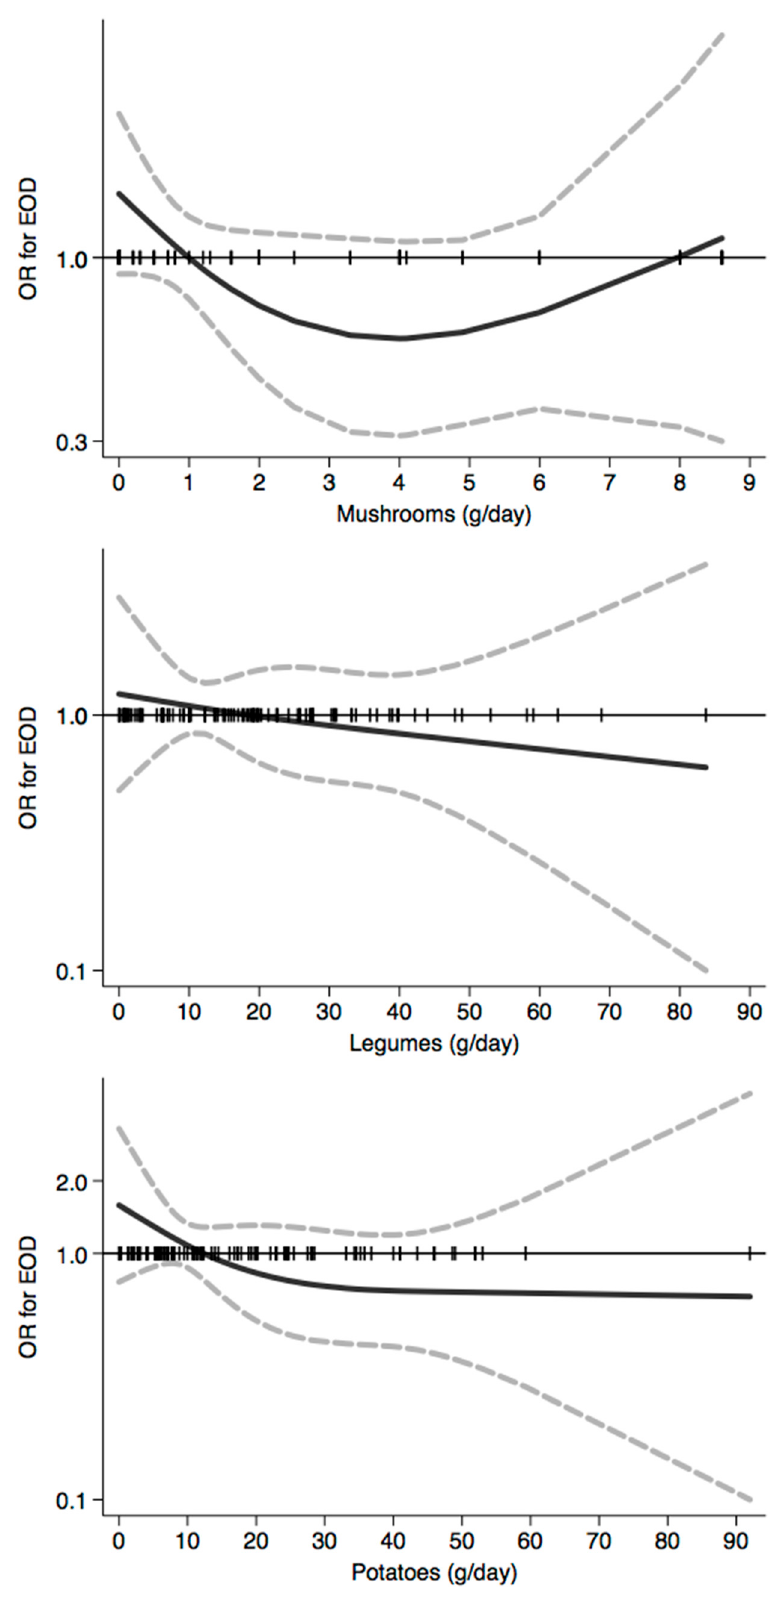
Figure 6. Spline regression analysis of early ‐ onset dementia (EOD) risk for increasing intake of mushrooms, legumes, and potatoes. The black line indicates odds ratios for dementia risk; dash gray lines are 95% confidence limits; the reference line at 1.0 with black spikes indicates the distribution of participant intake.